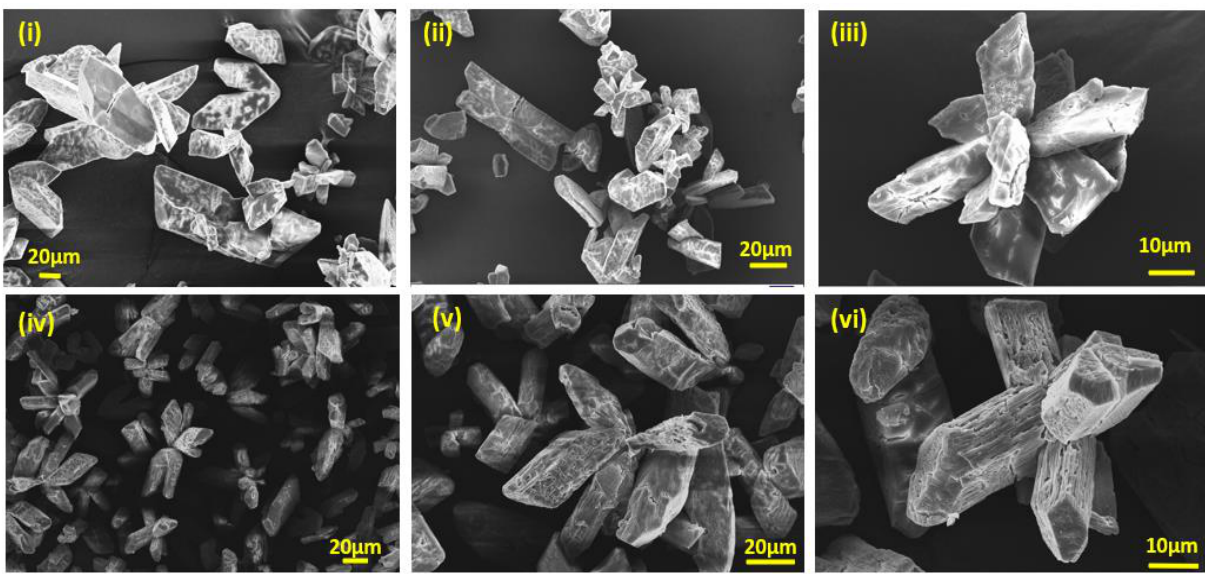
Figure 9. Scanning electron microscopy (SEM) photographs of struvite spontaneously precipitated by Method A ( i – iii ) and Method B ( iv – vi ).